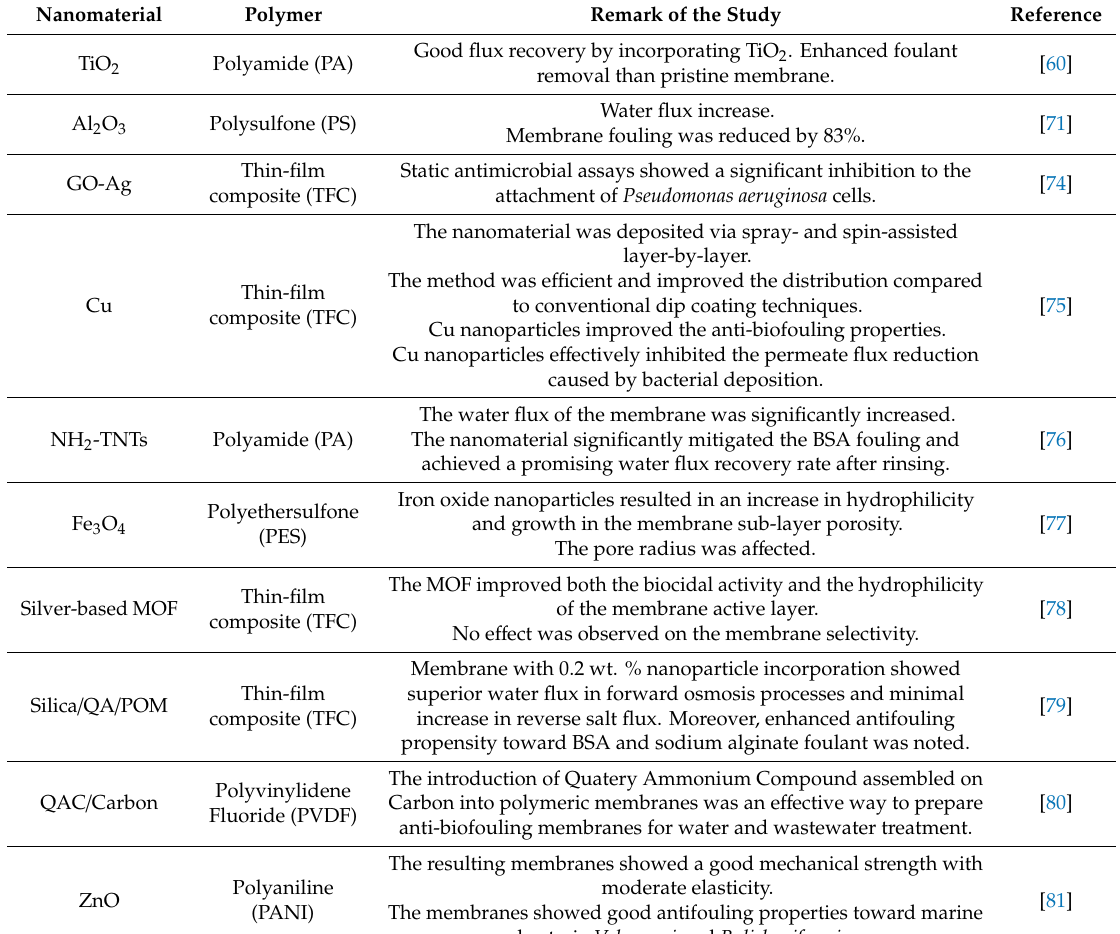
Table 4. Nanomaterials embedded in composite membranes for water